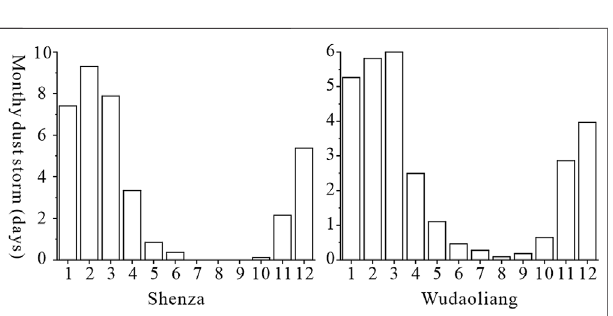
FIGURE 2 | Monthly dust storm days (average of 1961 – 2000) in the central Tibetan Plateau (Han et al., 2008).